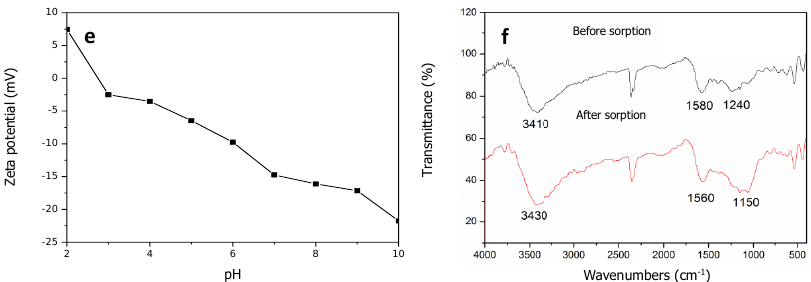
Figure 3. Characterizations of ( a ) SEM micrographs, ( b ) pore size distribution, ( c ) nitrogen adsorption-desorption isotherms, ( d ) X-ray diffraction result, ( e ) Zeta potential, and ( f ) FTIR spectra of Typha angustifolia activated carbon.